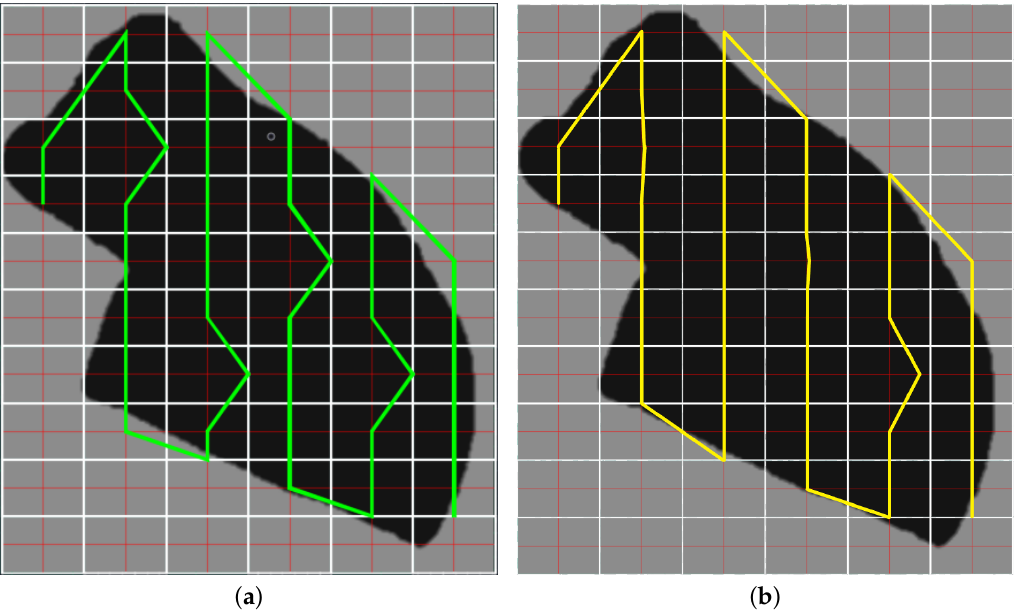
Figure 17. ( a ) total trajectory paths. Total path generated by our 2D basic obstacle avoidance algorithm; ( b ) total path generated in our 3D obstacle avoidance algorithm.